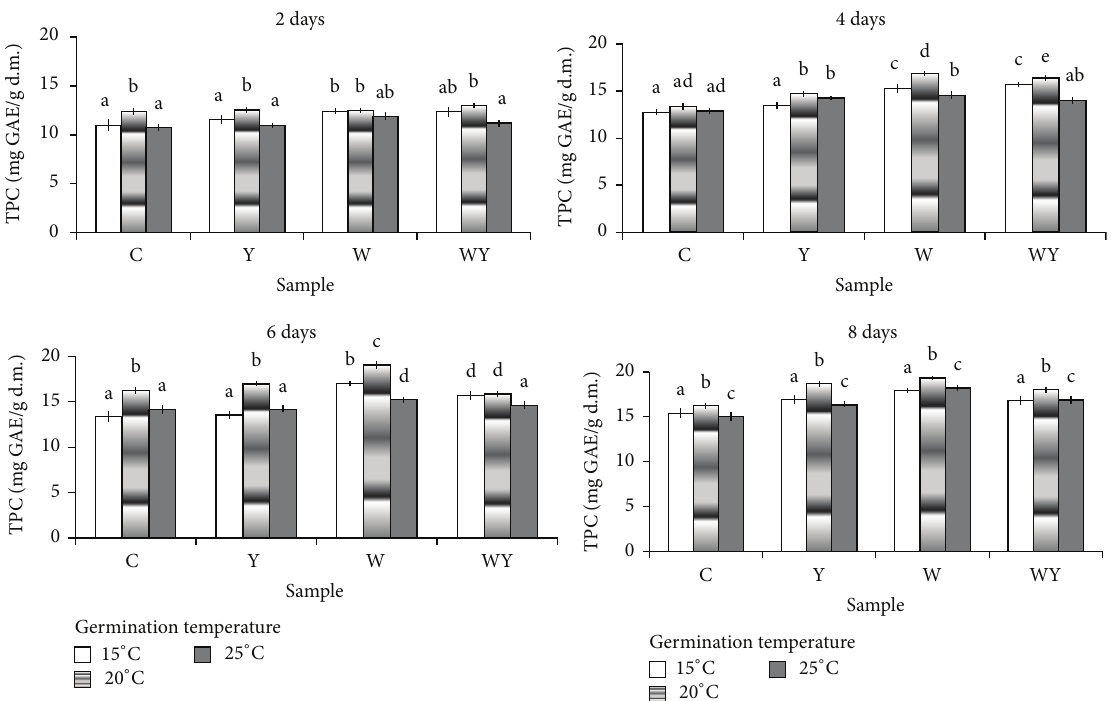
Figure 1: Total phenolics content in control and elicited sprouts depending on time of germination and germination temperature (cv. Bogatka);thevaluesdesignatedbythedifferentlettersforindividualdaysofsproutingaresignificantlydifferent( 𝛼 =0.05);Crepresentscontrol sprouts, Y represents sprouts elicited by yeast, W represents sprouts elicited by willow, and WY represents sprouts elicited by willow/yeast